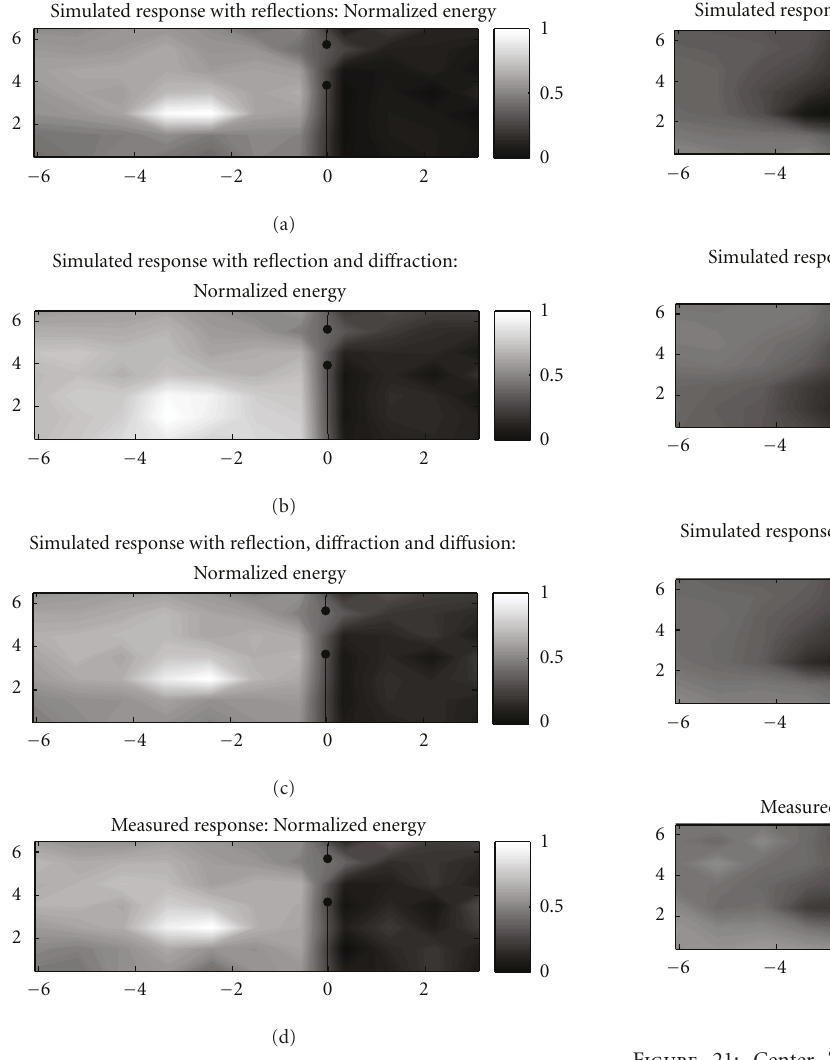
Figure 20: Normalized energy map: (a) simulated with reflections only, (b) simulated with reflections and di ff raction, (c) simulated with reflections, di ff raction and di ff usion, (d) measured.